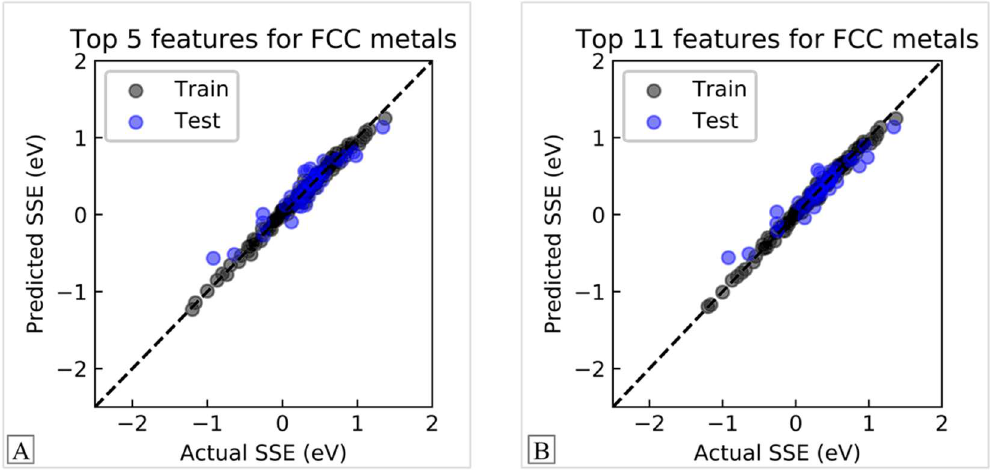
Table 4. RMSE, MAE and R 2 values for training and test sets obtained from the GBR model using 5 features.